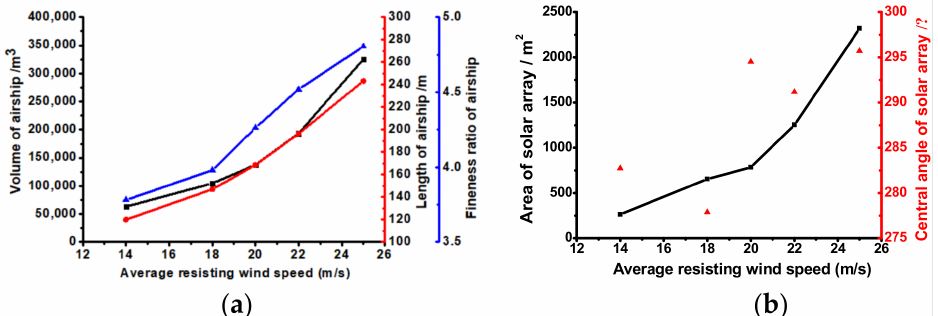
Figure 21. ( a ) The optimized volume, length, and fineness ratio of airships. ( b ) The optimized area and central angles of solar arrays for different average resisting wind